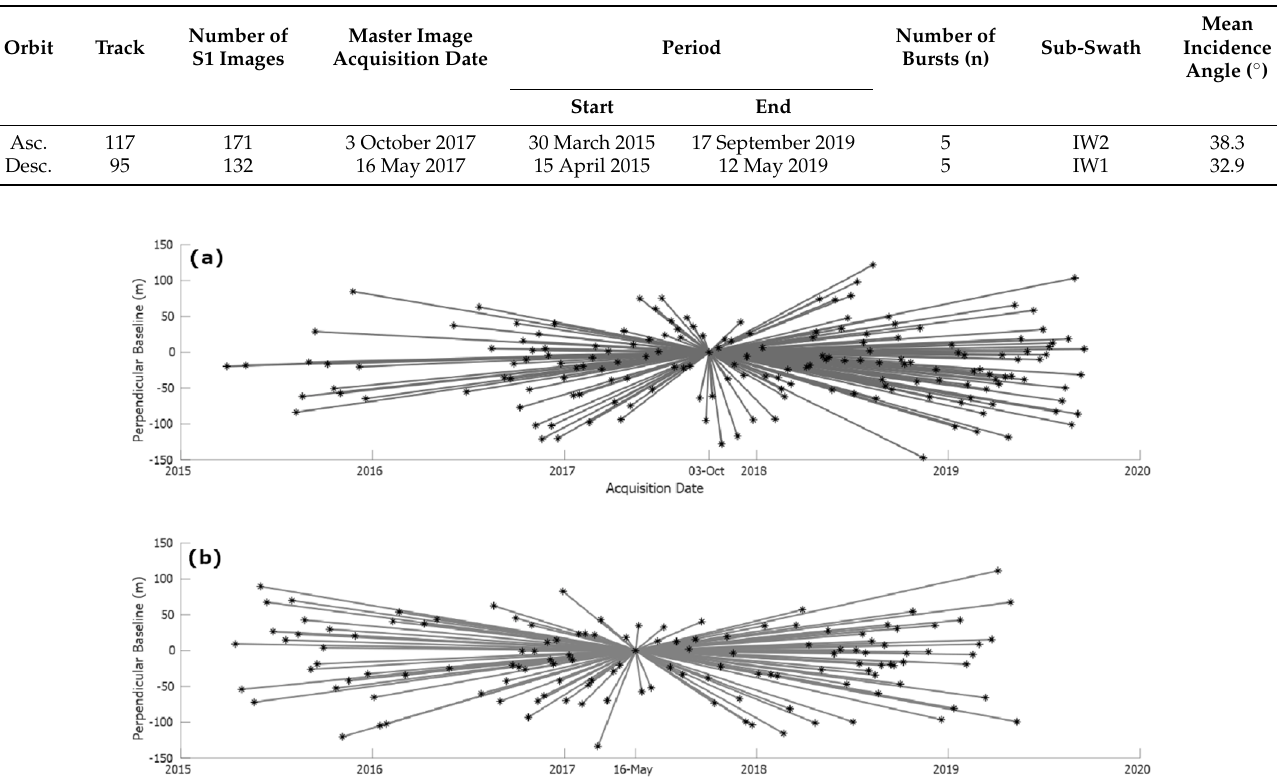
Table 1. The Sentinel-1 datasets used in this study.